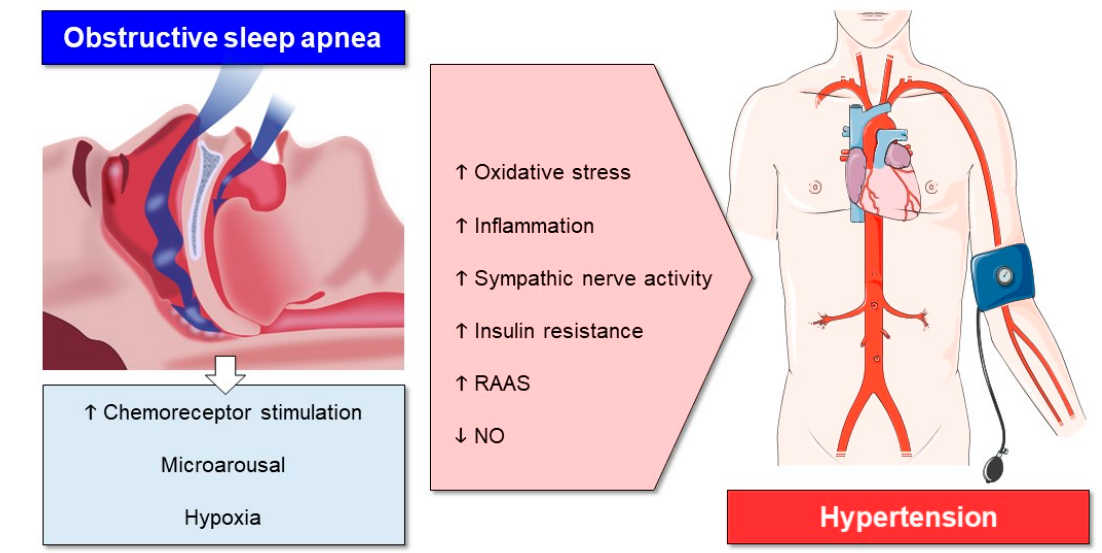
Figure 1. The mechanisms of OSA that lead to hypertension. ↑ : elevated; ↓ : reduced. Parts of this figure were produced using graphical elements from Servier Medical Art (available from https://smart.servier.com/), licensed under a Creative Commons Attribution 3.0 Unported License